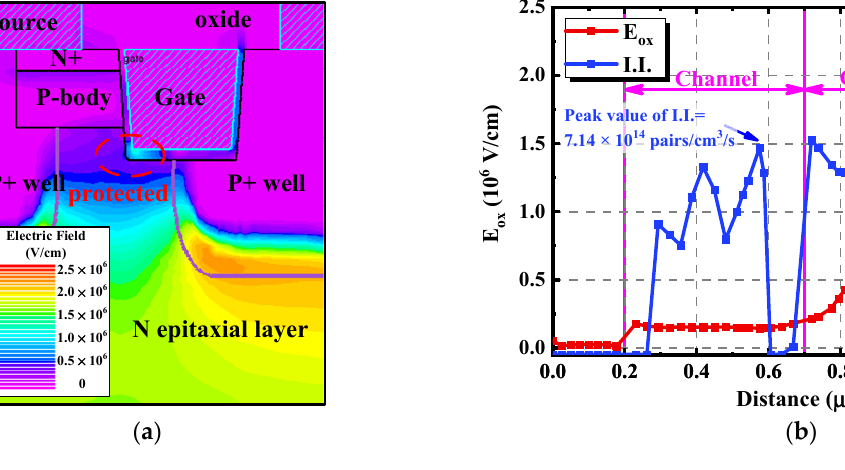
Figure 12. Physical characteristics of the asymmetric trench SiC MOSFET with an inclined channel under the avalanche state. ( a ) Distribution of the electric field. ( b ) Extracted E ox and I.I. along the gate oxide interface.